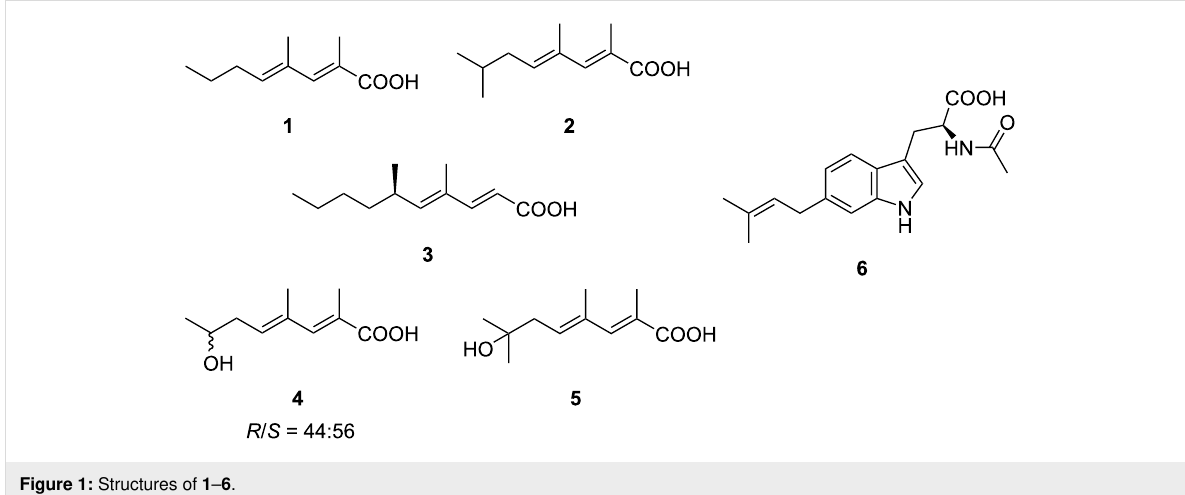
Figure 1: Structures of 1 – 6